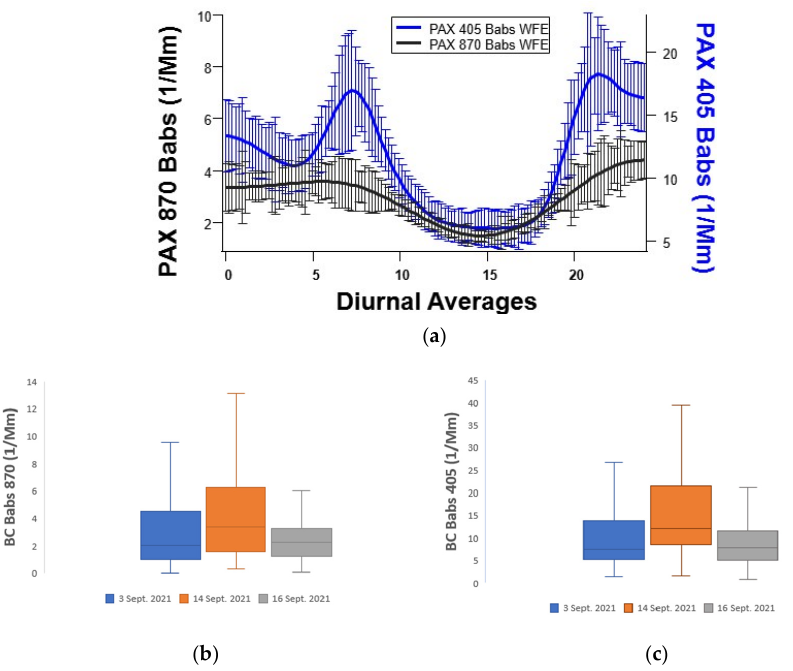
Figure 8. ( a ) shows the diurnal averages of the Babs due to BC particles of the eighteen wildfire event days of the season. The values on the left y -axis (in black) of the graph were reported by the PAX 870 nm, and on the right y -axis (blue) were calculated from the 405 nm PAX. The graph has a smoothing filter applied. The error bars in ( a ) represent the standard error associated with each averaged point. Boxplots were added to present the spread of the data over 10 min averages for three California wildfire event days, 3 September, 14 September, and 16 September. ( b ) shows the data spread for the BC Babs PAX 870 nm while ( c ) shows the spread of the BC Babs calculated from the PAX 405 nm.